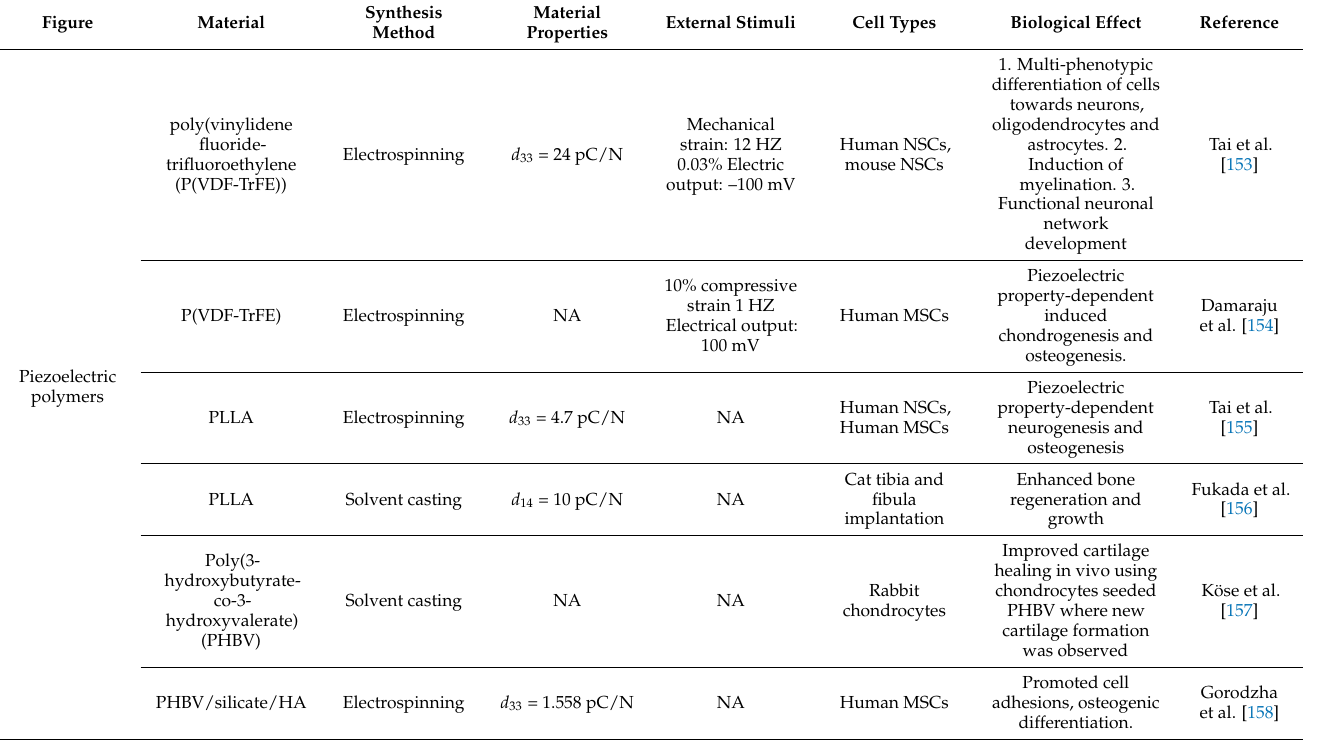
Table 4. Piezoelectric polymers and their tissue engineering applications. Figure